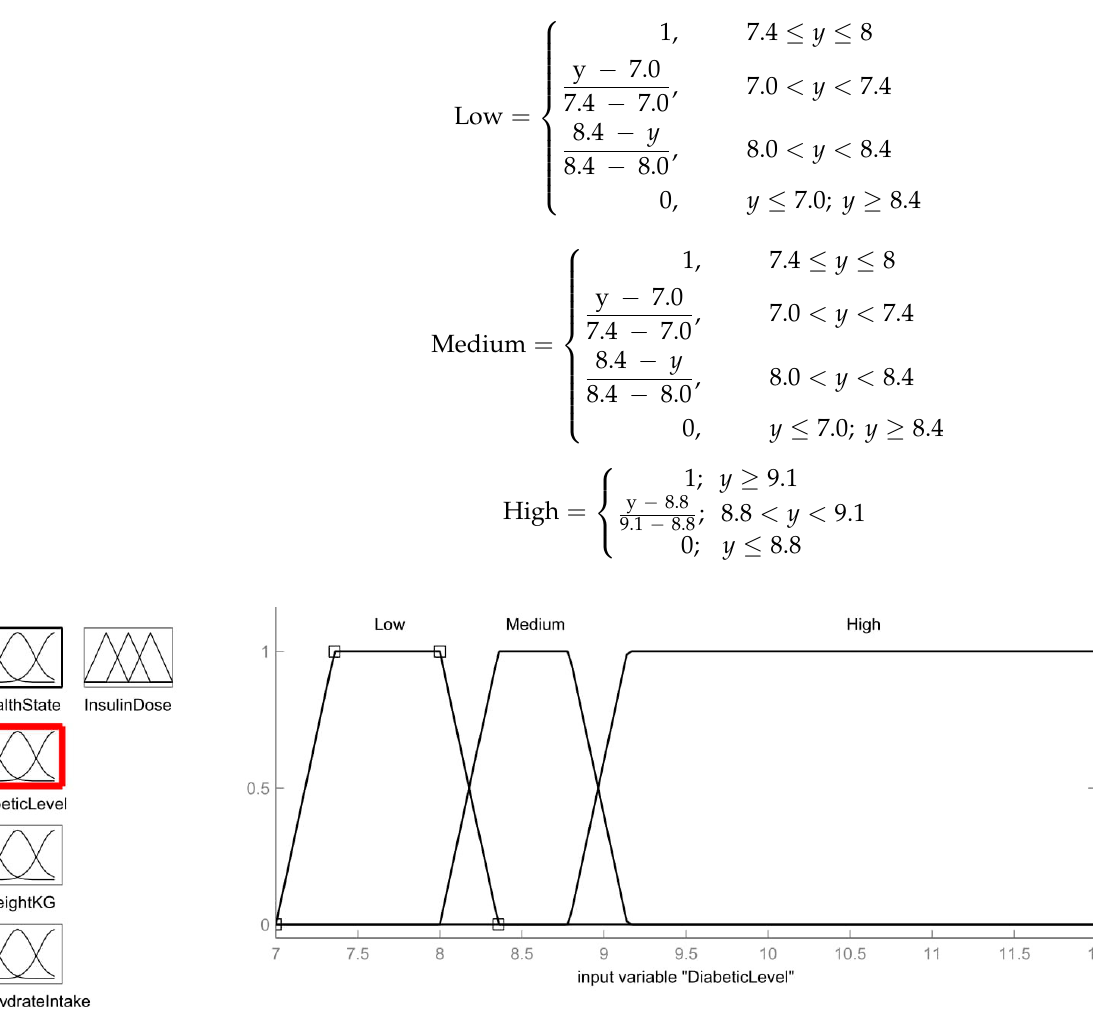
Figure 9. Diabetic Level Membership function.